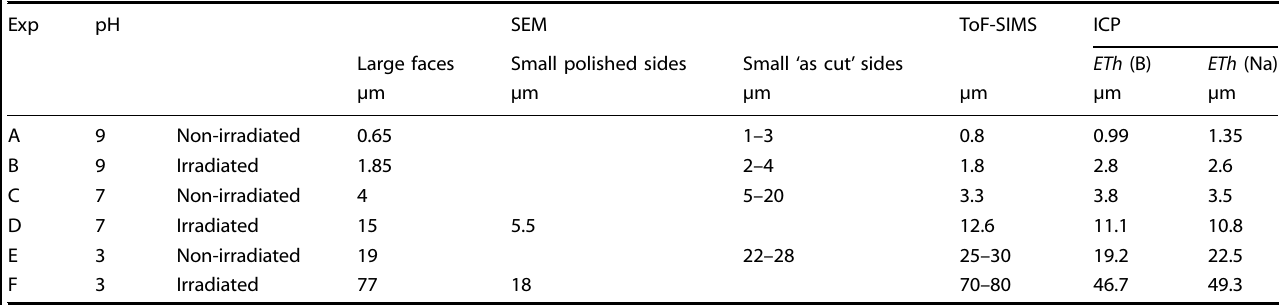
Table 2. Gel thickness obtained at the end of the experiments (83 days) by various methods.